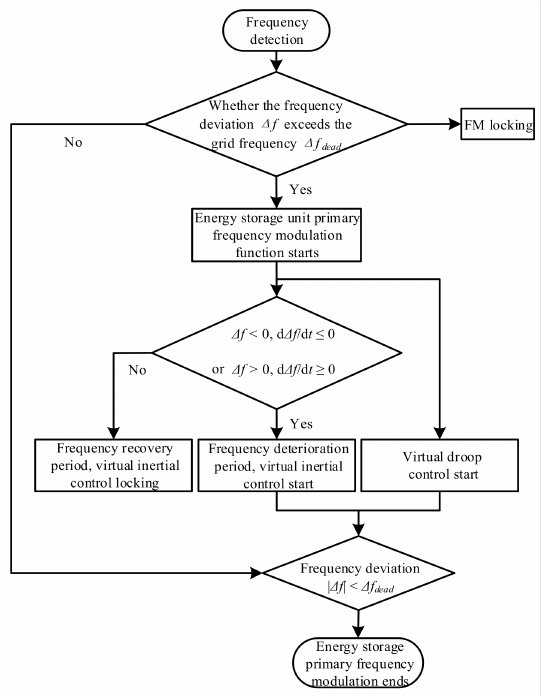
Figure 1. Process of control